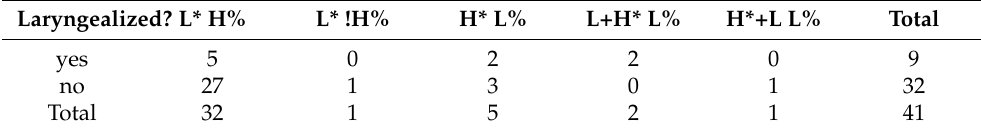
Table 7. Co-variation in laryngealization and choice of nuclear contour in tokens of [tama ː m] ‘okay’. Laryngealized? L*